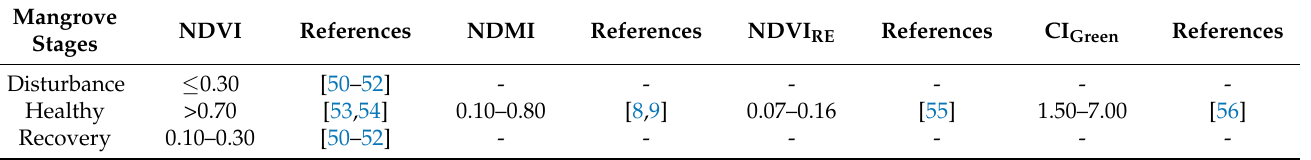
Table 2. Values of Vegetation Indices for Discrimination of Mangrove Stages/Previous Studies.